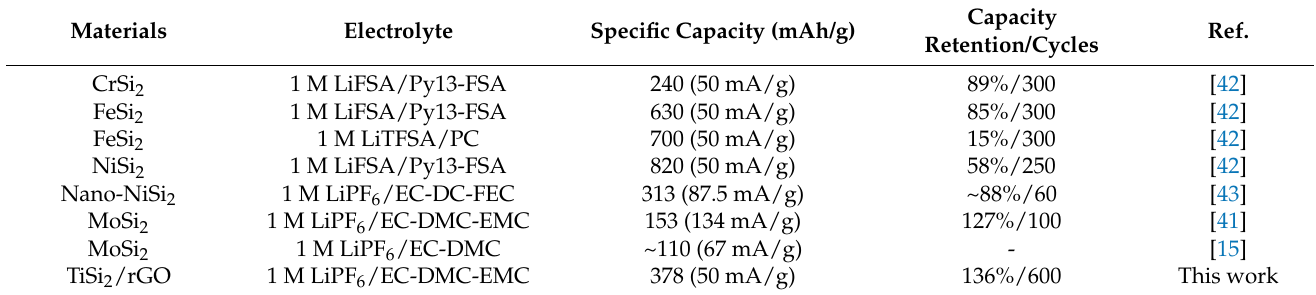
Table 1. Comparison of electrochemical performance of different inactive transition metal silicides. Materials Electrolyte Specific Capacity (mAh/g)